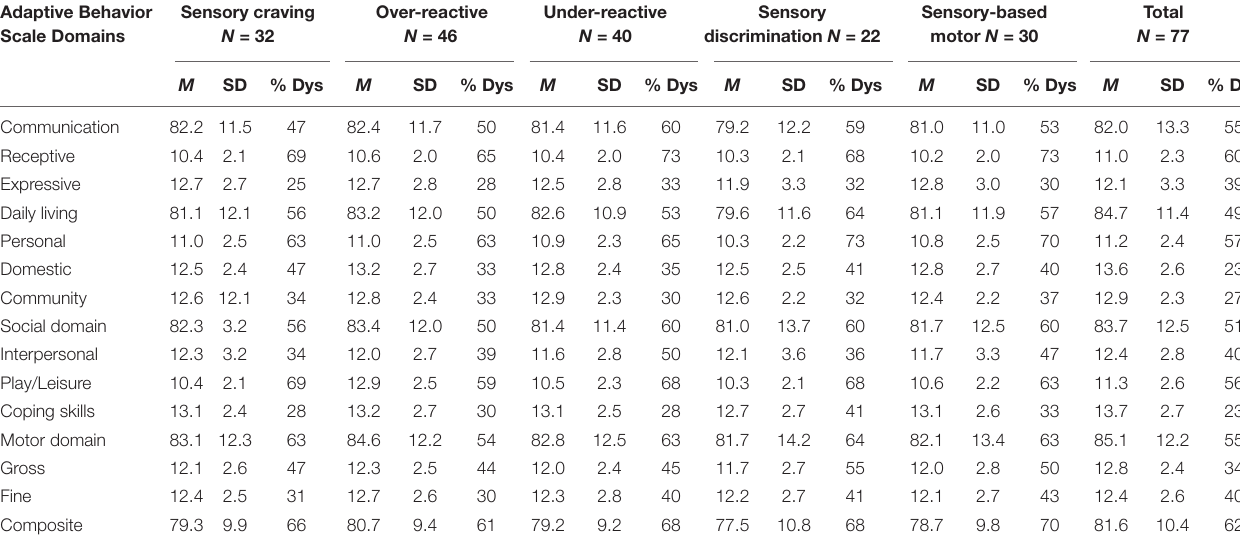
TABLE 3 | Vineland Adaptive Behavior Scales-II mean domain standard scores ( M = 100, SD = 15) and subdomain scaled scores ( M = 15, SD = 5). Adaptive Behavior Sensory craving Over-reactive Under-reactive Sensory Sensory-based Scale Domains N = 32 N = 46 N = 40 discrimination N = 22 motor N =